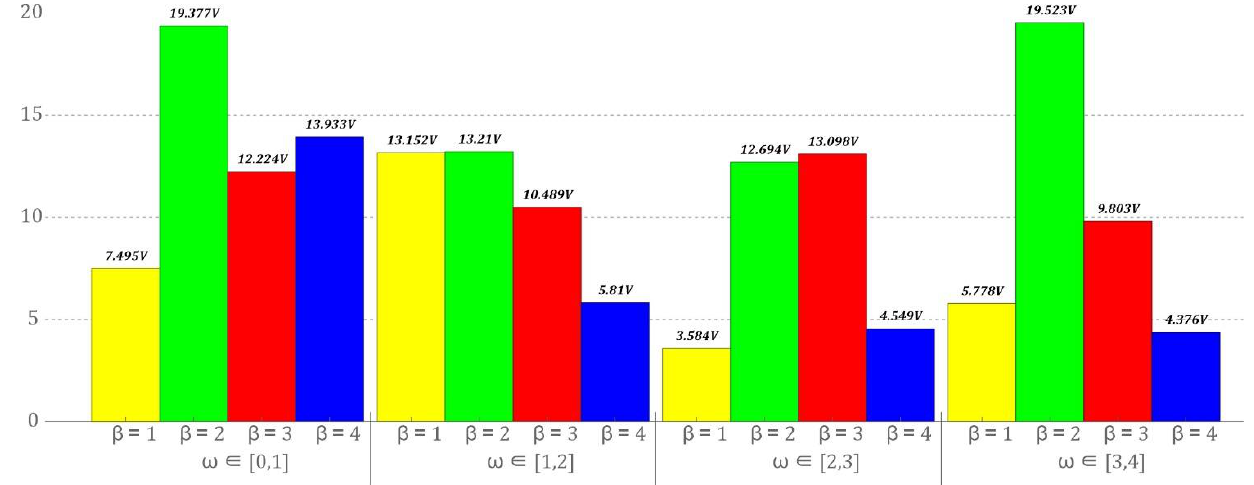
Figure 17. Comparison of the efficiency of harvesting energy in selected bands of variability of the dimensionless excitation frequency ω .